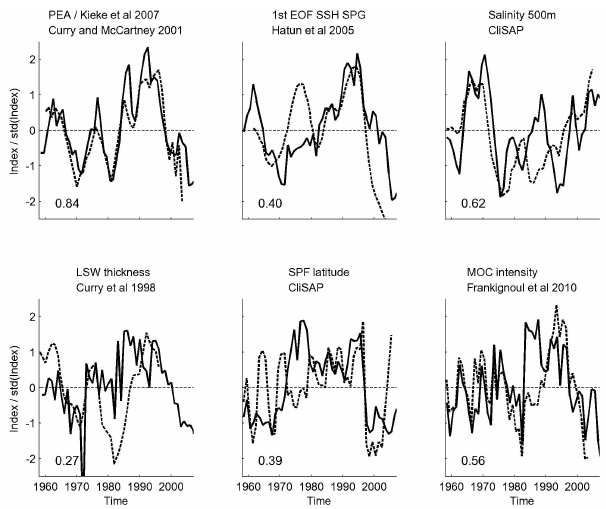
Fig. 2. Comparison between our simulated (solid lines) and ob- served or previously simulated (dashed lines) indices derived from non-filtered annual data of PEA (upper left panel), gyre intensity index as first EOF of SSH (upper middle panel), mean salinity at 500m depth in the subpolar region (upper right panel), LSW thick- ness in its formation area (lower left panel), mean latitudinal posi- tion of the SPF in the NFB (lower middle panel) and MOC intensity (lower right panel). The numbers inside the panels are the correla- tion between the corresponding solid and dashed